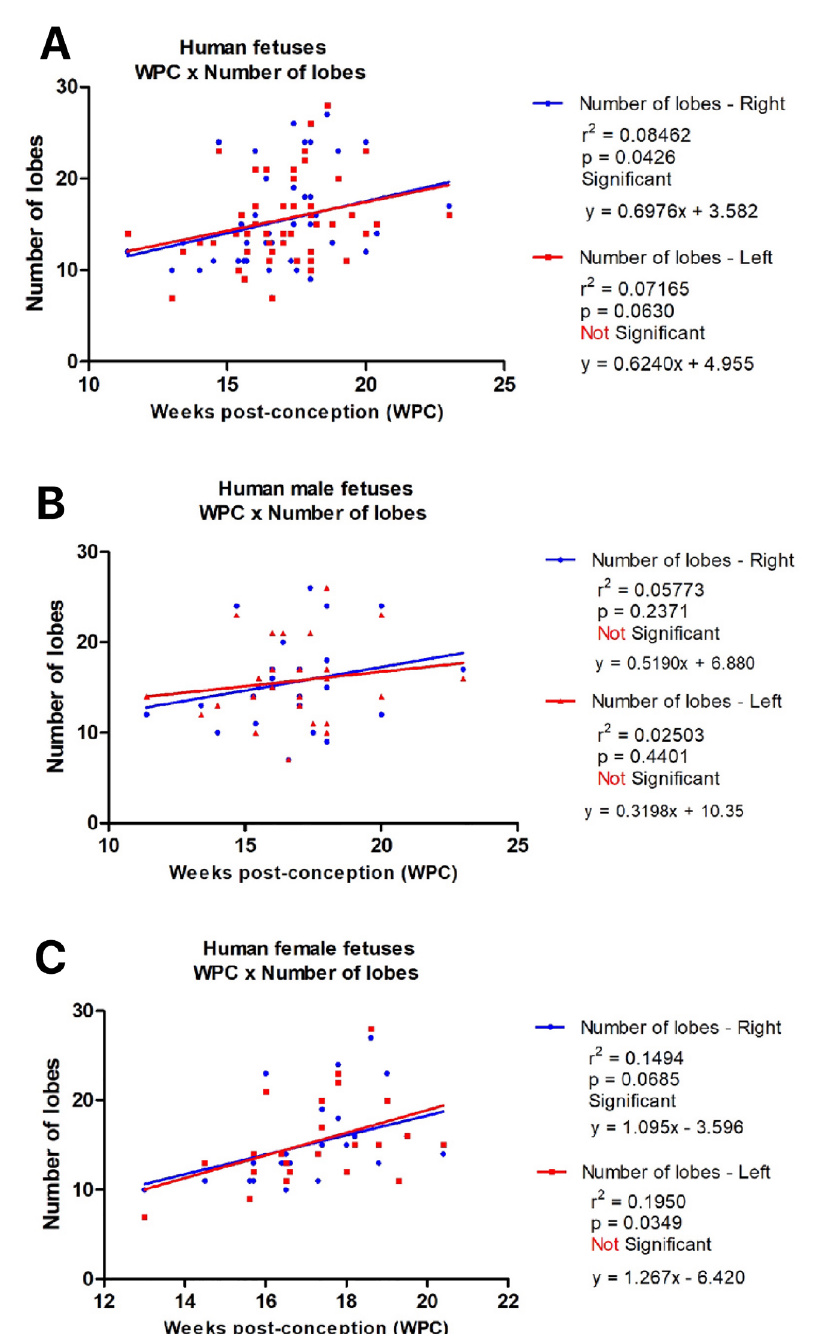
Figure 2 - Linear regression analysis comparing the correlation of the renal clefts and fetal age (WPC).